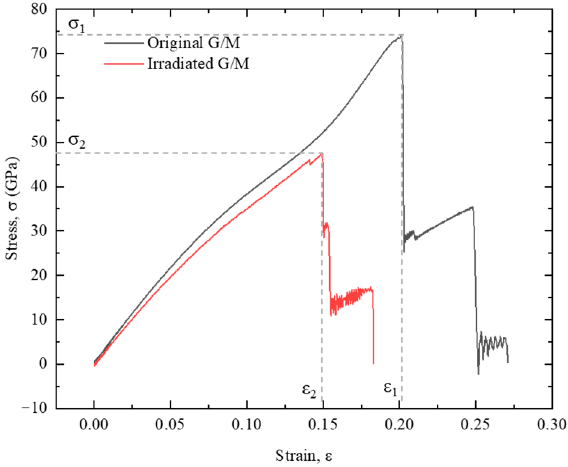
Figure 10. Stress-strain relationship of the G/M heterostructure with and without the ion irradiation process. The irradiation parameters are 200 eV, 1.27 × 10 16 /cm 2 .